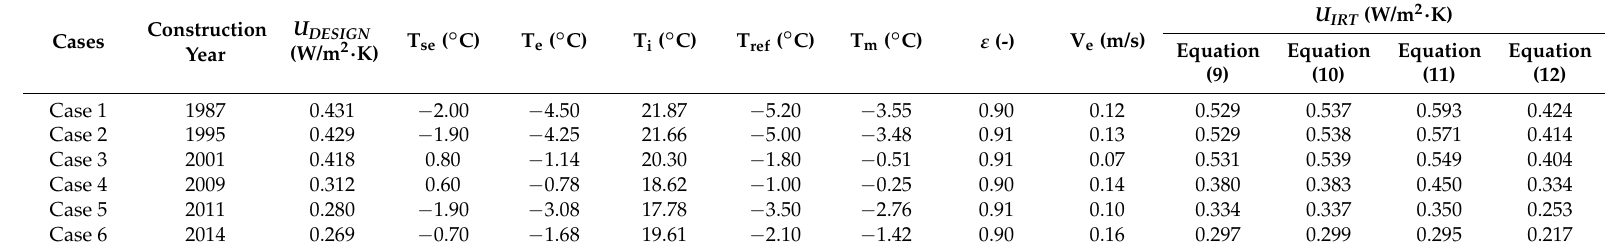
Table 4. U -values obtained through infrared thermography method with four different equations together with required